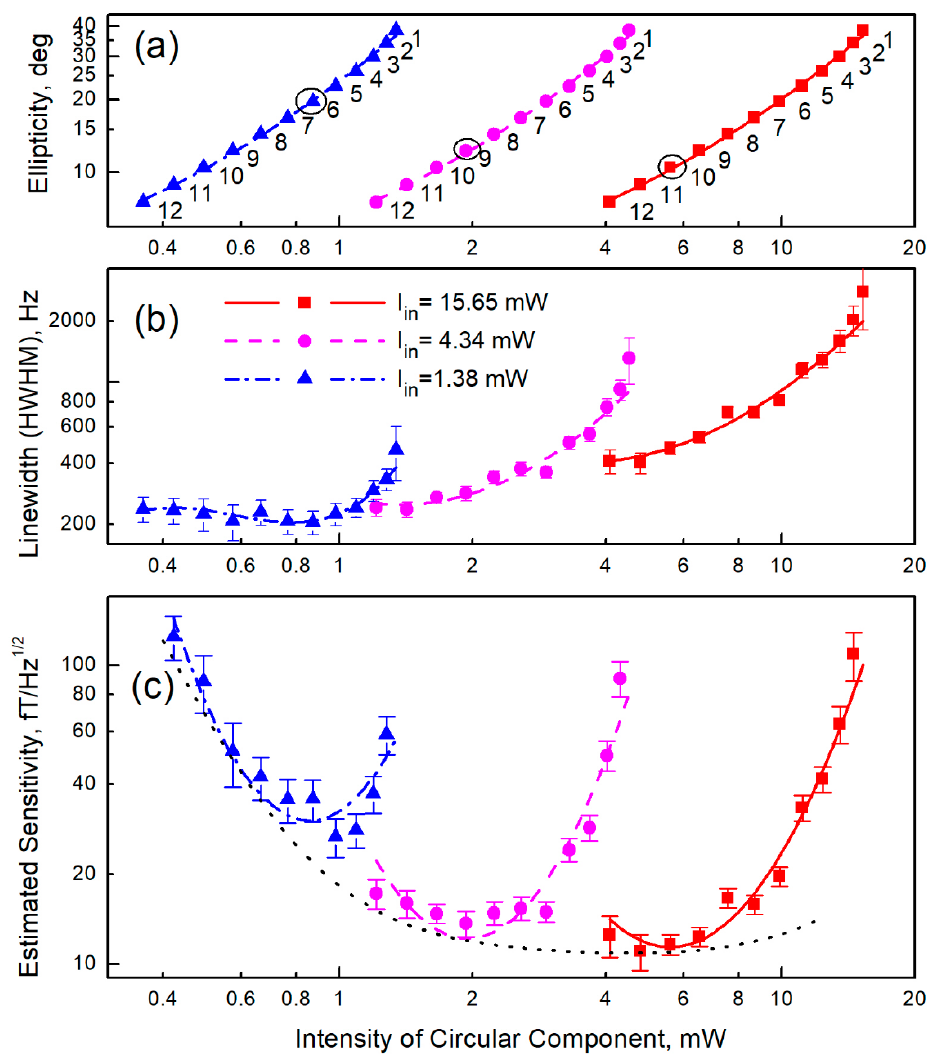
Figure 3. Dependence of the parameters of magnetic resonance when pumped with light with modulated ellipticity on the light intensity at the input of the cell: ( a ) ellipticity for different numbers (indicated by numbers in the graph field) of glass plates in a linear polarizer; the black circles indicate the optimal ellipticity values for this series, ( b ) magnetic resonance half-width, ( c ) estimation of the ultimate (limited by calculated shot noise) sensitivity. Connecting lines are guides to the eye.